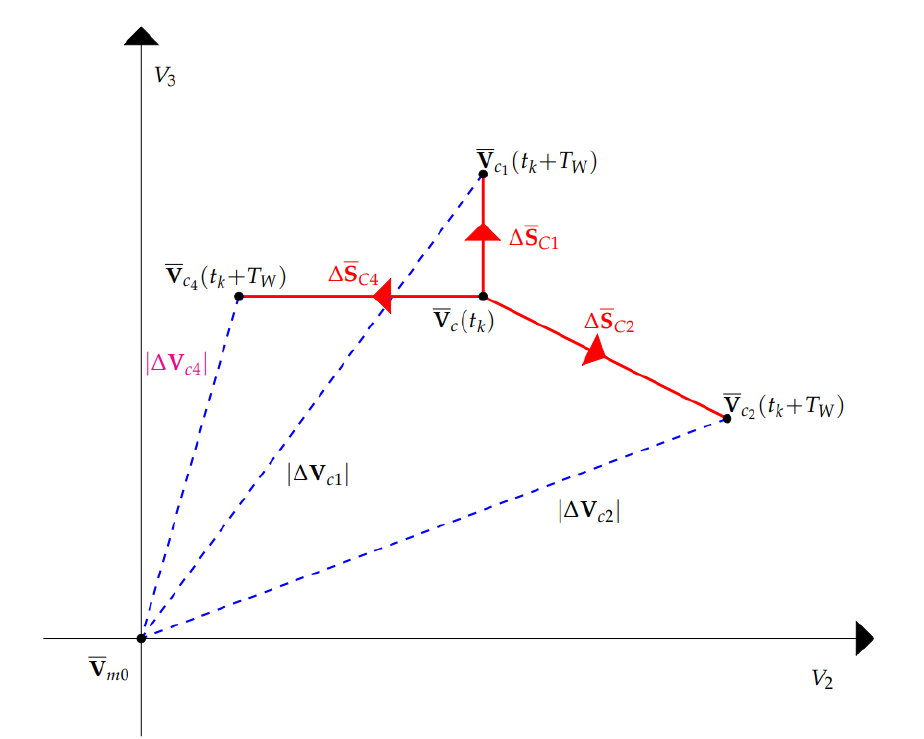
Figure 12. Calculations of the Minimum Distance algorithm in the case of n = 3, m = 4, V m = [ 3 2 1 ] T when the desired output level is α =